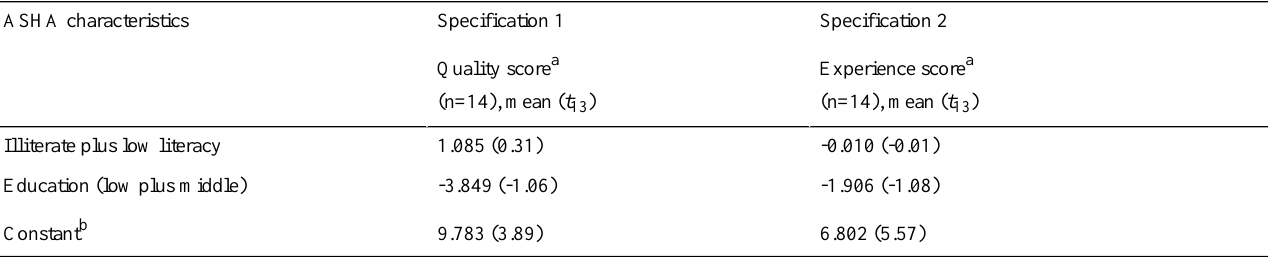
Table 11. The effect of literacy and education levels on quality and experience of